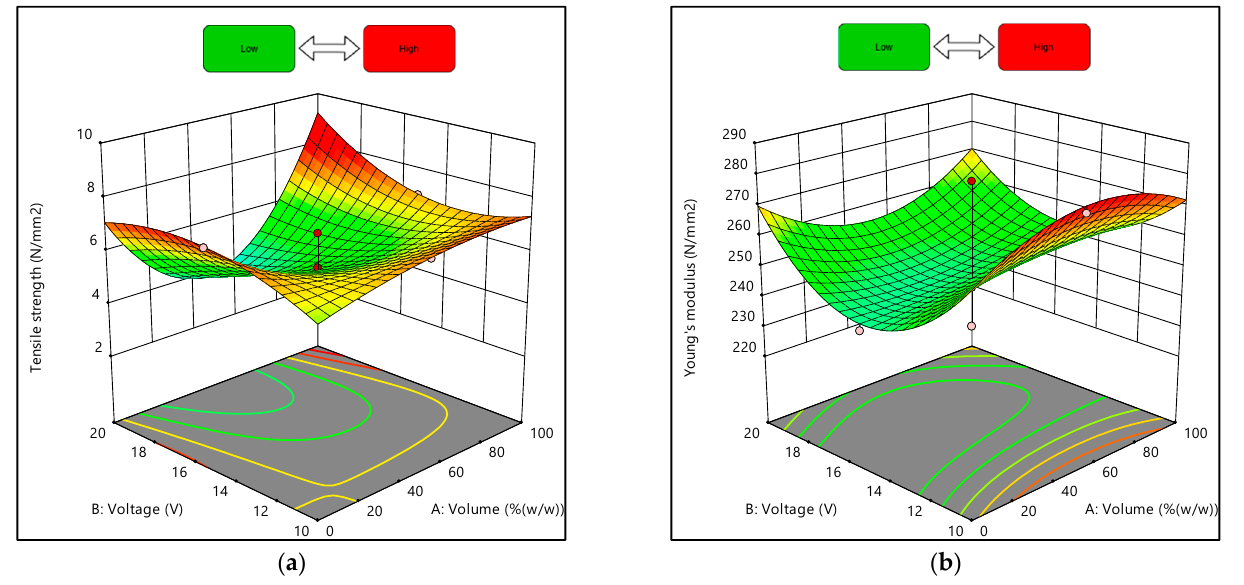
Figure 7. Three-dimensional response surface plots for experimental designs of 0% and 100% water: ( a ) Tensile strength, ( b ) Young’s modulus.